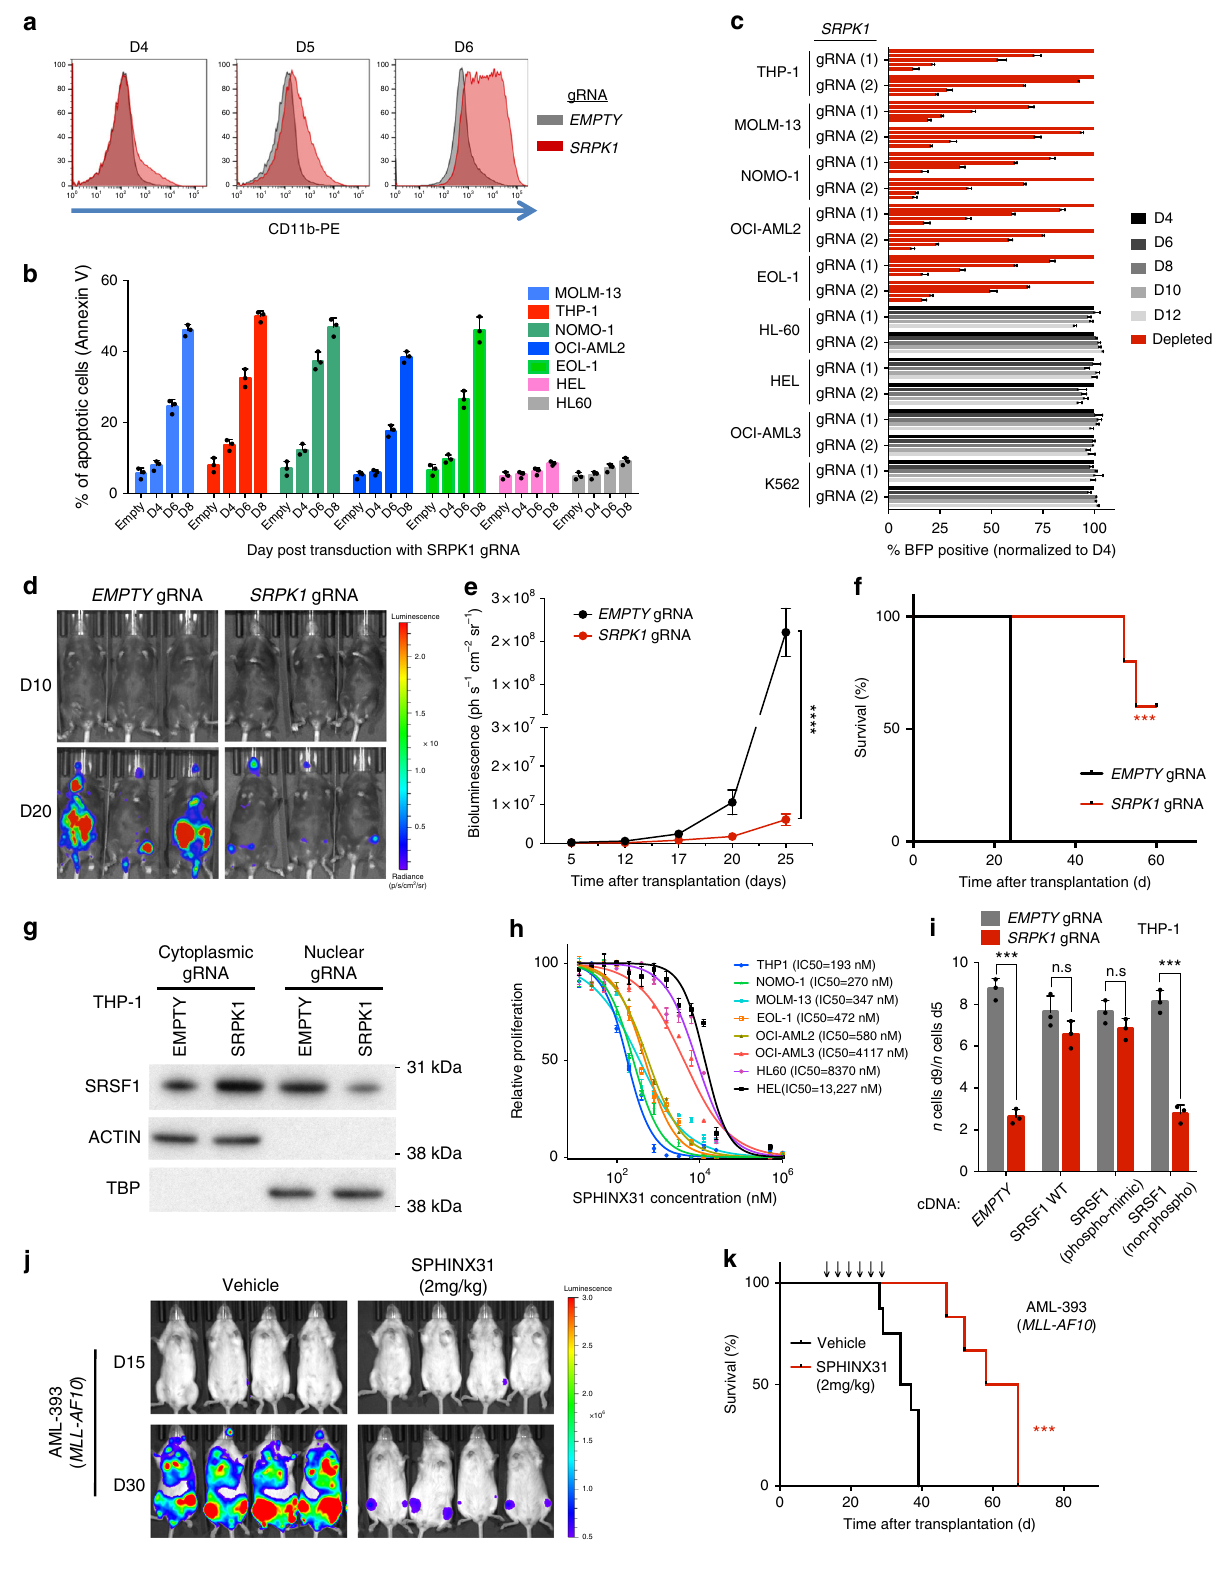
programs (Supplementary Fig. 8d, Supplementary Data 1, 2). Splicing analysis of both pharmacological (Fig. 3a) and genetic (Supplementary Fig. 8e) inhibition of SRPK1 revealed diverse changes with exon skipping as the most common event,